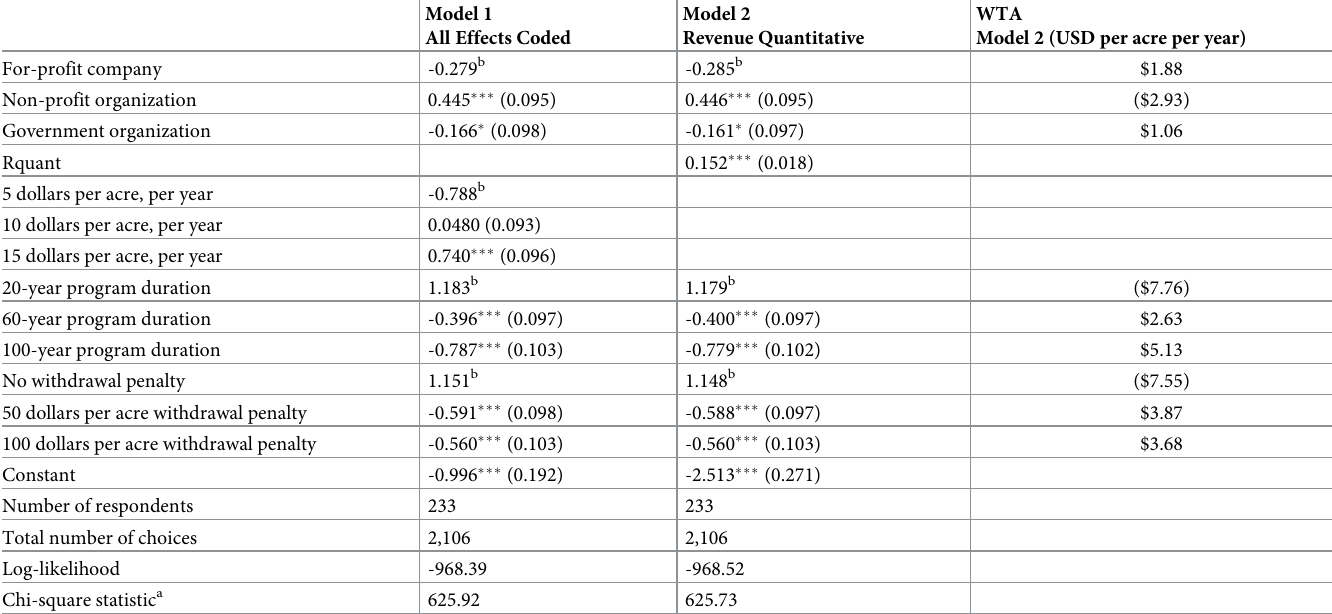
Table 6. Results from binary-choice model: Random effects logit